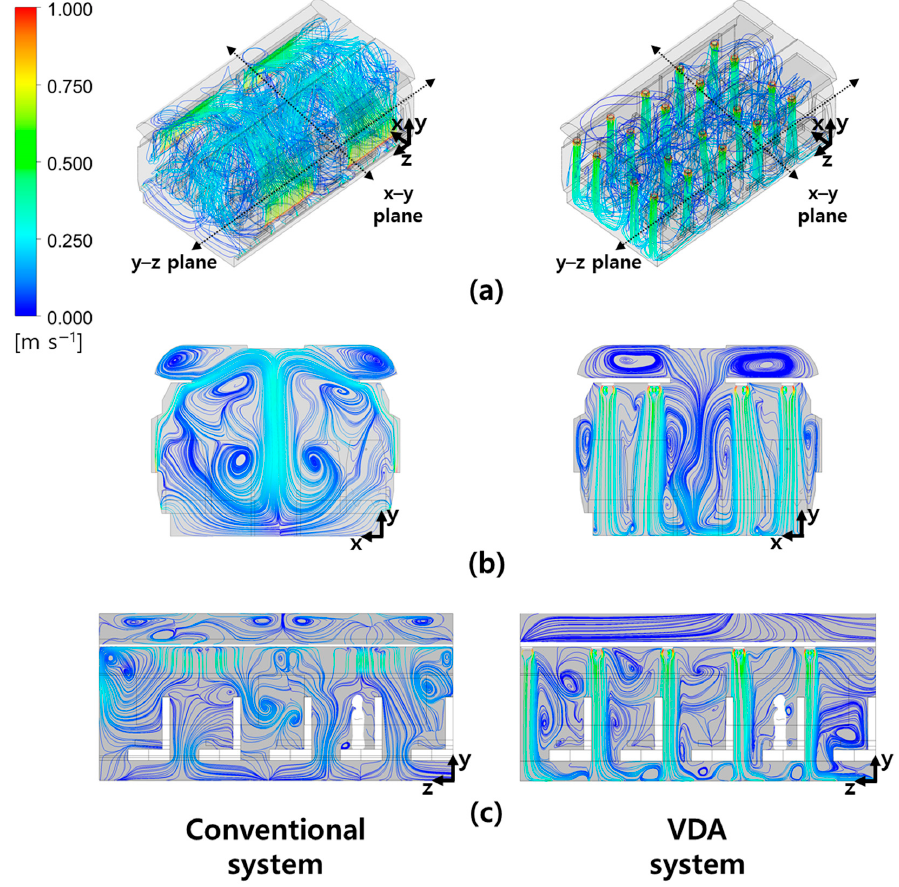
Figure 6. Streamline in the high-speed train cabin considering the conventional and VDA systems: ( a ) isometric view; ( b ) x–y plane; and ( c ) y–z